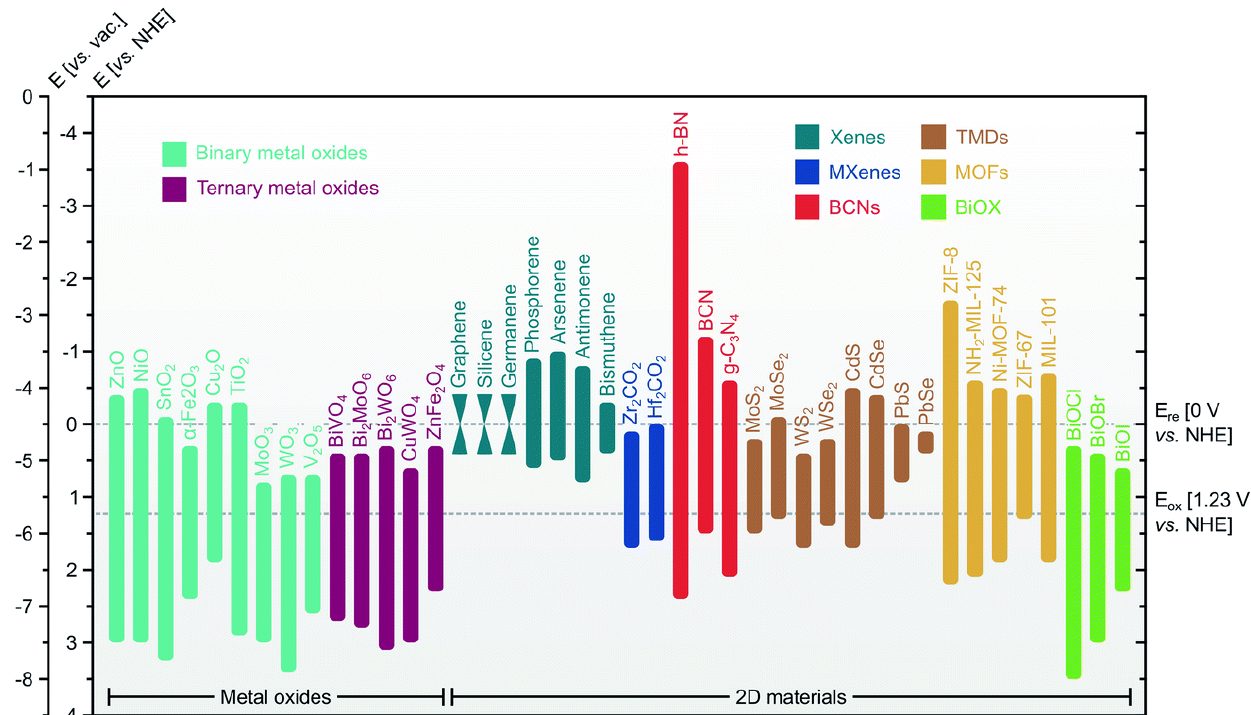
Figure 11. Band positions of various metal oxide and non − oxide semiconductors and 2D materials. Reproduced from Ref. [86] with permission from the Royal Society of Chemistry. In order to explore the photocorrosion of CuO, Xing et al. [26] had tested hetero- junctions CuO: CuO/TiO 2 , CuO/Pt, and CuO/TiO 2 /Pt as photocathodes. Under in- creased protection of the photocathodes, allowed increase of the photocurrent density at − 0.55 V, as shown in Figure 10j. The composite of CuO/TiO 2 /Pt had the highest photocur- rent density. In addition, according to the Figure 10k, CuO/TiO 2 /Pt seems to have a very good photo-response, at − 0.55 V vs. Ag/AgCl applied under 30 s light on/off cycles for at − 0.55 V vs. Ag/AgCl under simulated sunlight illumination for 2 h, Figure 10l. The